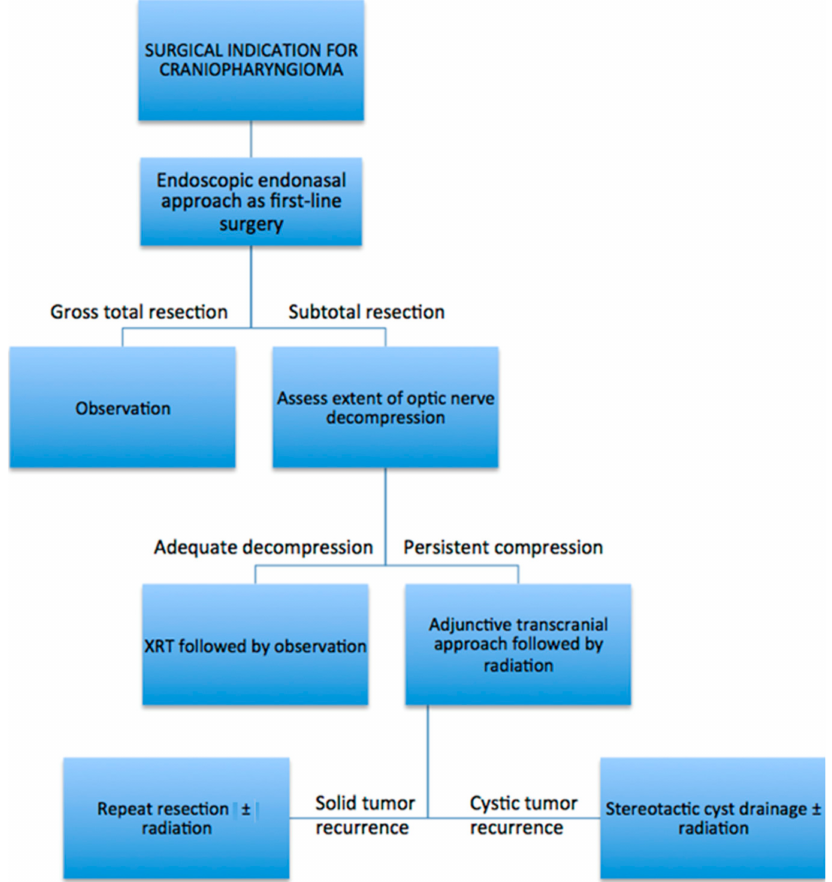
Figure 5. Simplified schematic depicting treatment approach after endoscopic endonasal resection of adult